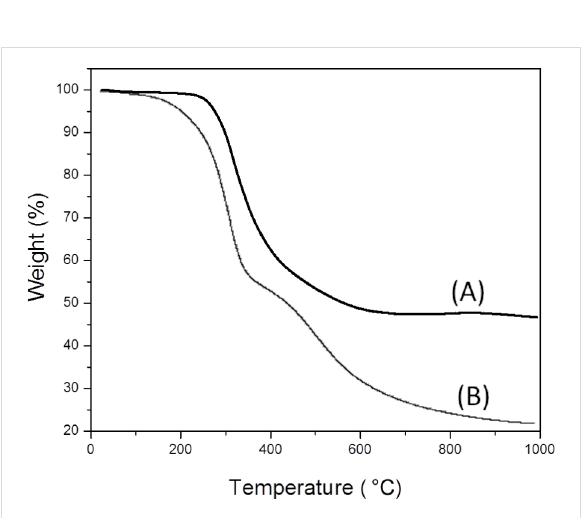
Figure 3: Thermogravimetric behavior of the Au@HS-CNC (4.4 mol %) catalyst (A) and CNC (B).